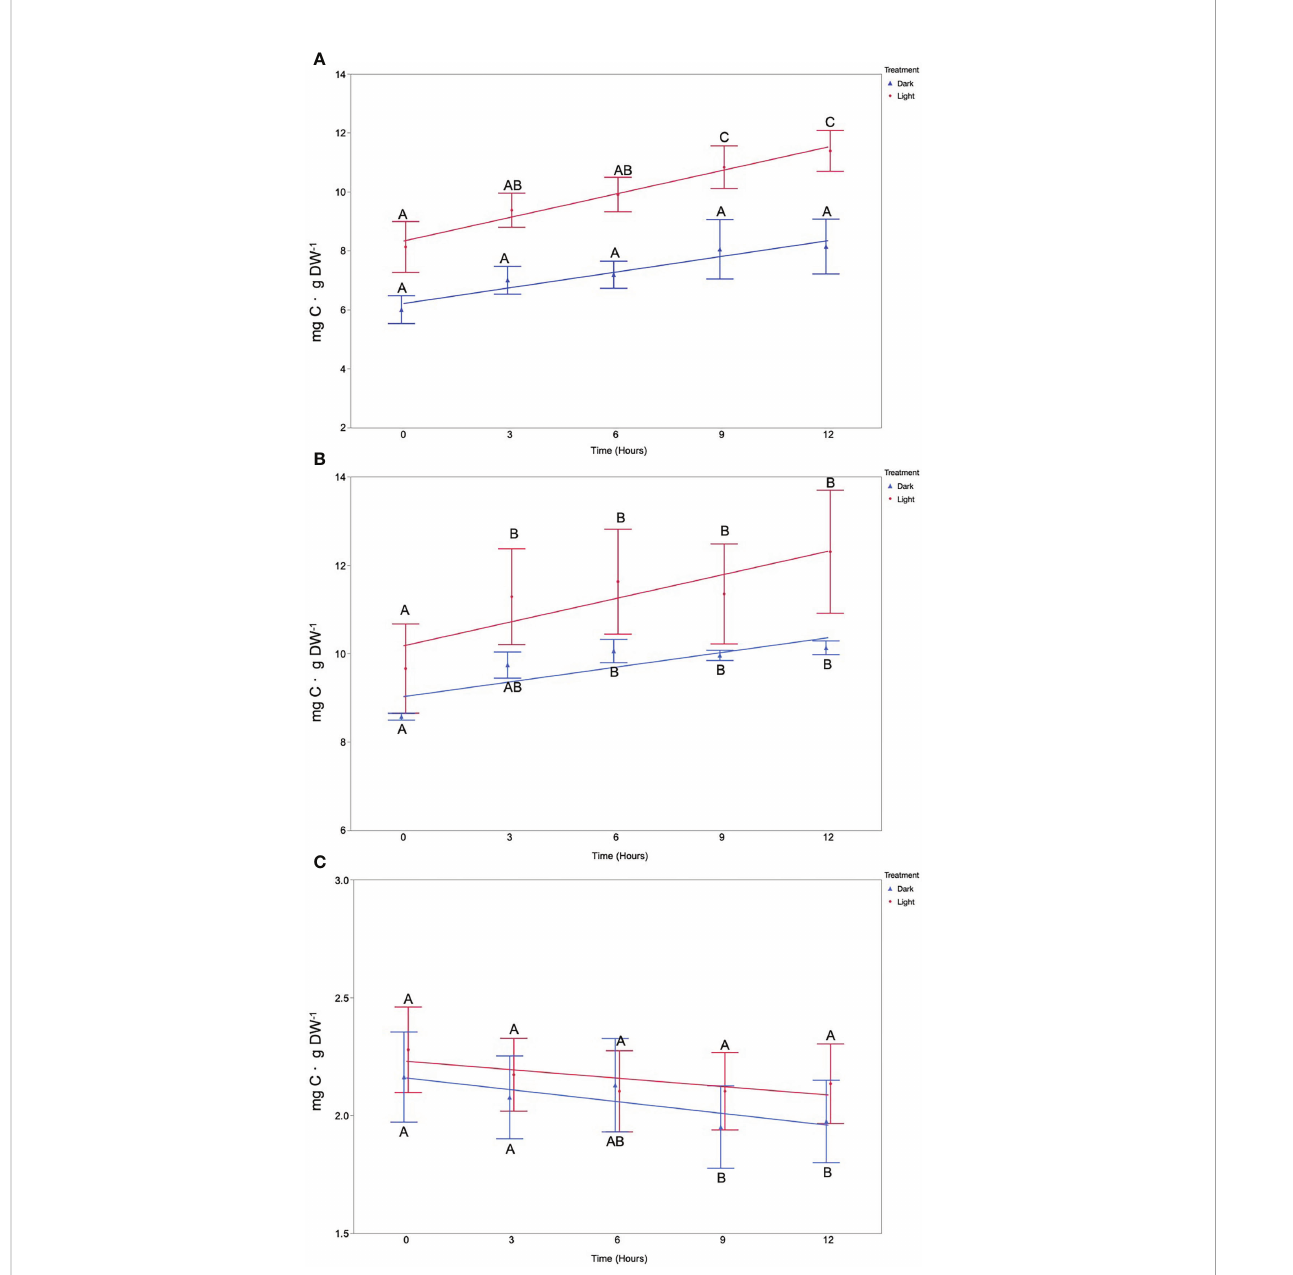
FIGURE 2 Total dissolved organic carbon concentration per milligram of dry weight of algal material over a 12-h period under light and dark treatments for the species (A) ( F ) vesiculosus , (B) U . intestinalis , and (C) (F) lumbricalis . Different letters indicate signi fi cantly different DOC concentrations (mean ± 1 SE, n = 5) (Tukey ’ s HSD, a =